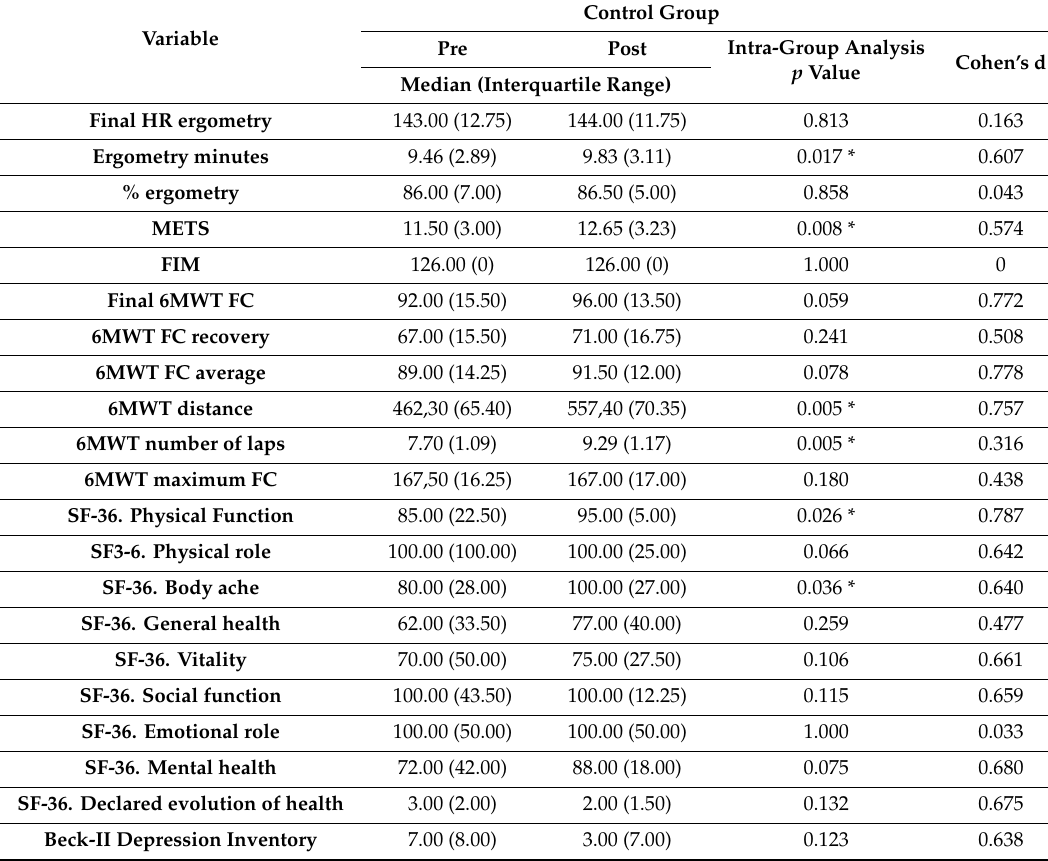
Table 3. Comparison outcome measures control group (intra-group analysis).